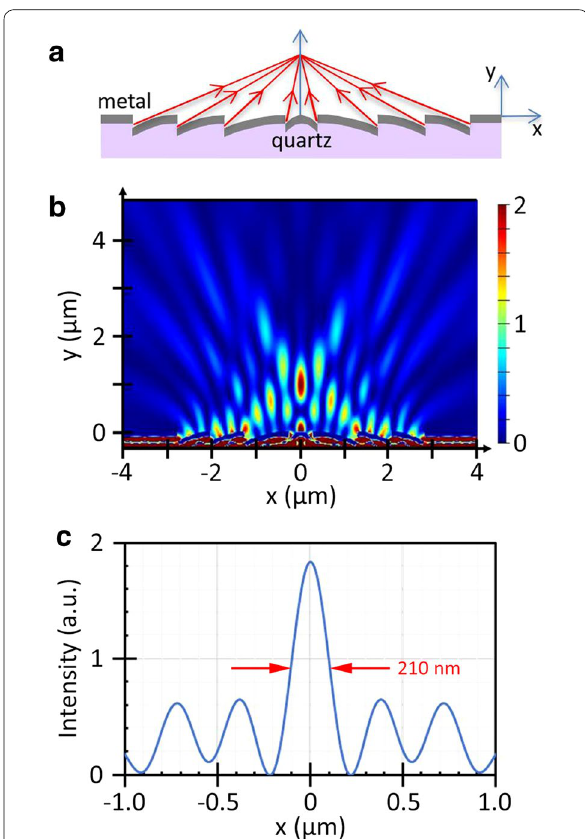
Fig. 3 Beam focusing by a tilted nanoslit array lens. a Schematic cross-section of an 8-slit Ag nanolens designed for 2 λ focal length at λ 633 nm. b FDTD simulation of transmission pattern: field intensity = distribution. c The intensity distribution scanned at y central peak shows 210 nm FWHM, corresponding to 0.33